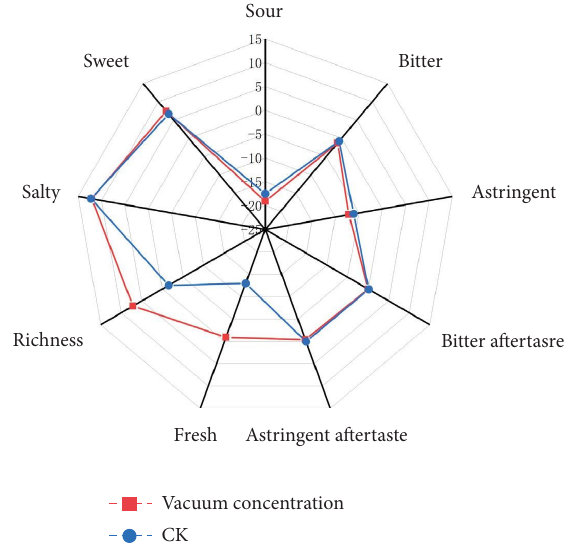
Figure 10: Taste radar map of “Yali” pear paste prepared under traditional and vacuum concentration